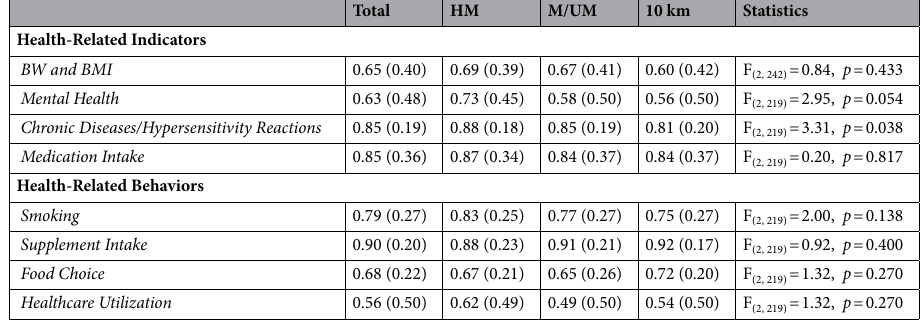
Table 4. Domain scores of ‘health-related indicators’ and ‘health-related behaviors’ of endurance runners, displayed by race distance groups. Data are presented as Domain Scores and (SD): Low scores indicate detrimental health effects; high scores indicate beneficial health effects (scales: 0–1). BMI body mass index, BW body weight, HM half-marathon, km kilometers, M/UM